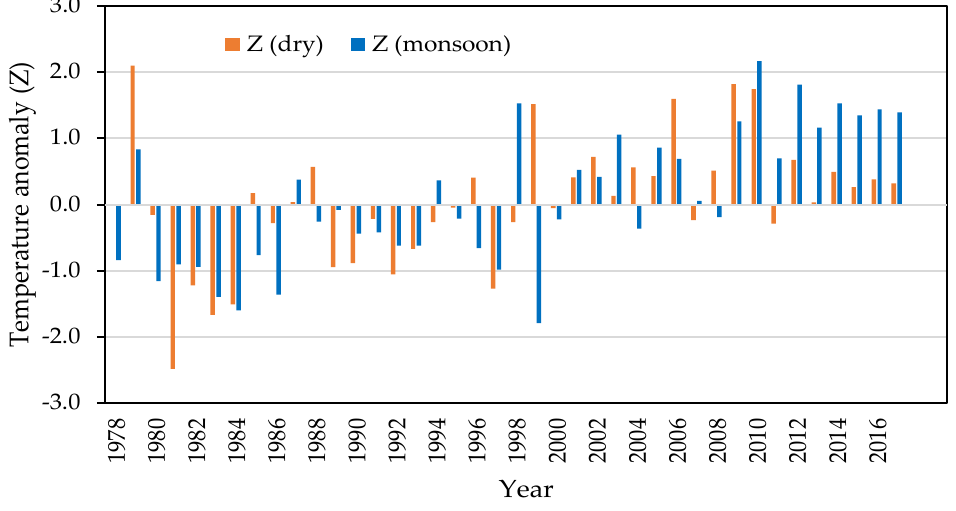
Figure 3. Standardized anomaly ( (cid:1852) ) in seasonal average temperature at Khulna (1978–2017).